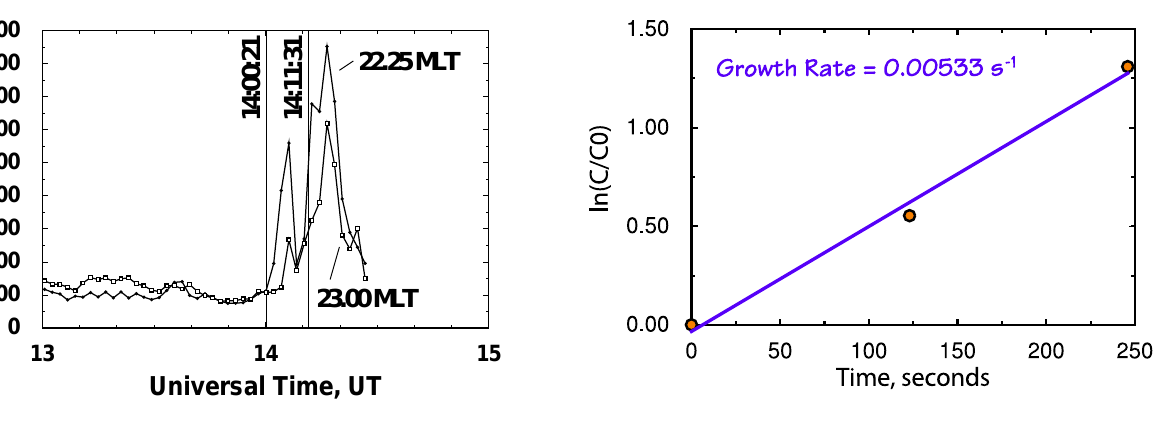
Fig. 5. Peak counts within growth phase arc at 22.25MLT and 23.00MLT as a function of time.